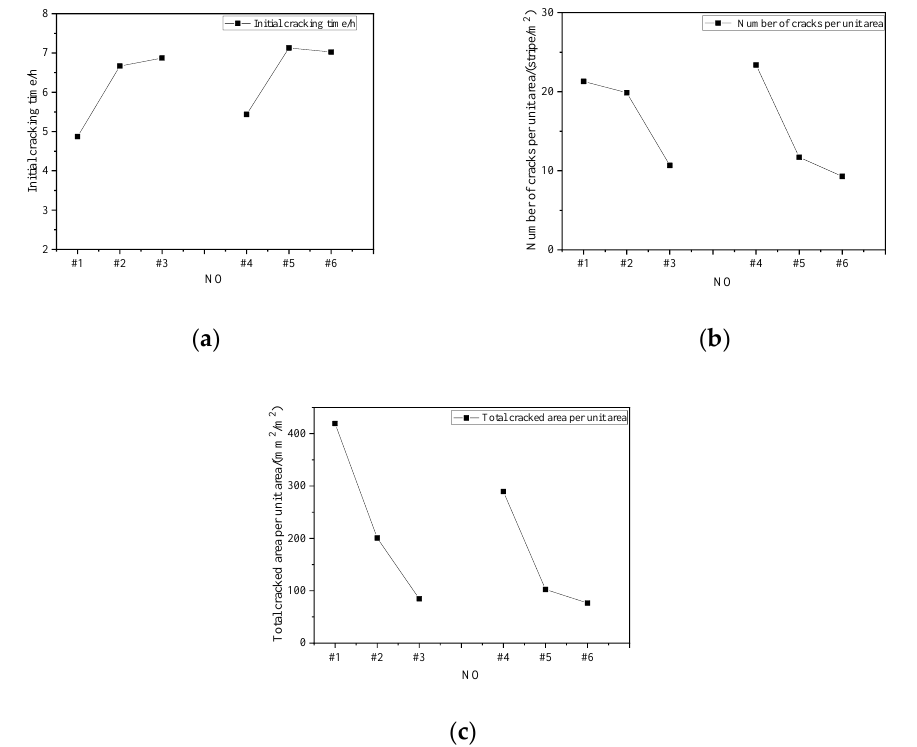
Figure 6. Comparison of early crack resistance of concrete in groups #1~#6: ( a ) Initial cracking time; ( b ) number of cracks per unit of area; ( c ) total cracked area per unit of area.